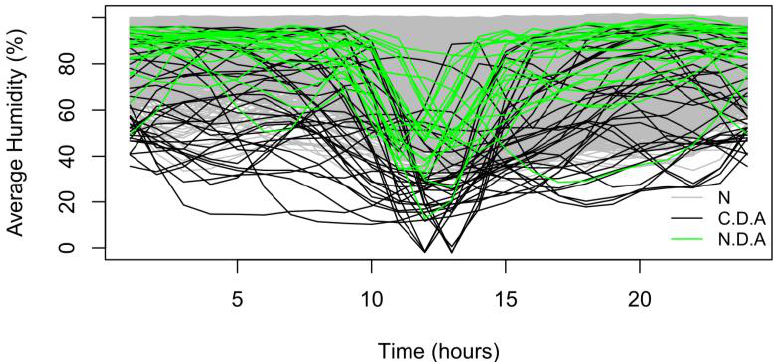
Figure 6. Relative humidity curves at the Tixán meteorological station. In gray are shown the curves that do not obey anomalies are shown, in black are shown the curves correctly identified as anomalies using the FD-LOCI procedure, while in green are identified the actual anomalous curves that have not been detected using the FD-LOCI model.